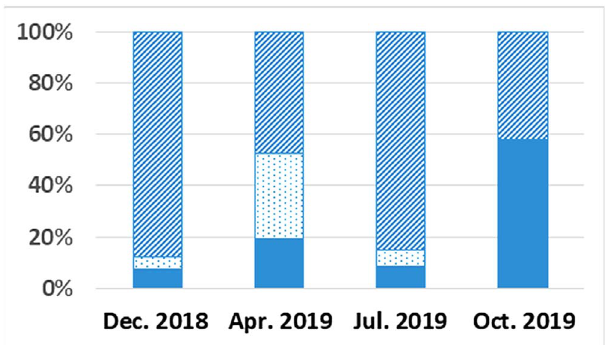
Figure 8. Proportions of females of acanthocephalan Acanthogyrus ( Acanthosentis ) cf. tilapiae in Coptodon guineensis at Sebkha Imlili according to stage of maturity. Solid bars = immature females (no genitalia visible); dotted bars = ovigerous females (ovarian balls visible); striped bars = gravid females (December 2018: n = 41; April 2019: n = 42; July 2019: n = 47; October 2019: n = 50). Gravid females were present throughout the year but signi fi cantly more abundant proportionally in December and July, which may indicate a short life span of the worms and quick turnover in the fi sh.